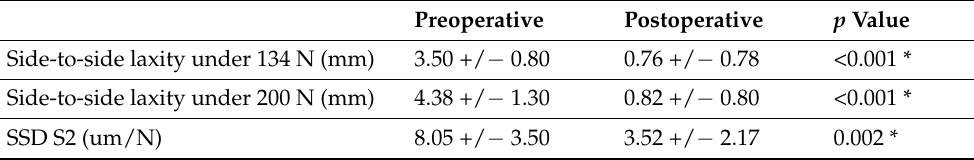
Table 3. Outcomes of GNRB arthrometer measurement. Preoperative Postoperative p Value Side-to-side laxity under 134 N (mm) 3.50 +/ − 0.80 0.76 +/ − 0.78 <0.001 * Side-to-side laxity under 200 N (mm) 4.38 +/ − 1.30 0.82 +/ − 0.80 <0.001 * SSD S2 (um/N) 8.05 +/ − 3.50 3.52 +/ − 2.17 0.002